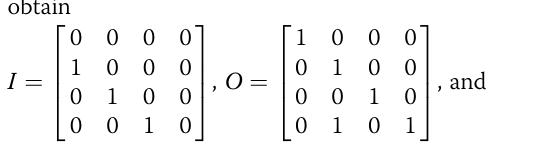
Table 3 Probabilities of the causes (scenario state) Causes (scenario